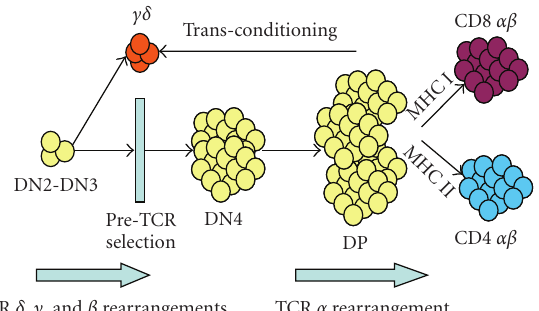
Figure 1: T Cell Development. γδ T cells most often arise from the CD4 − CD8 − (double negative, DN) stages of thymocyte development as a result of successful rearrangements of both the γ and δ TCR chains. Little, if any, proliferation occurs between these steps, thus limiting diversity. Signals delivered in trans from the CD4+CD8+ (double positive, DP) population is crucial for the development of e ff ector functions in γδ cells. Figure adapted from Hayday and Pennington